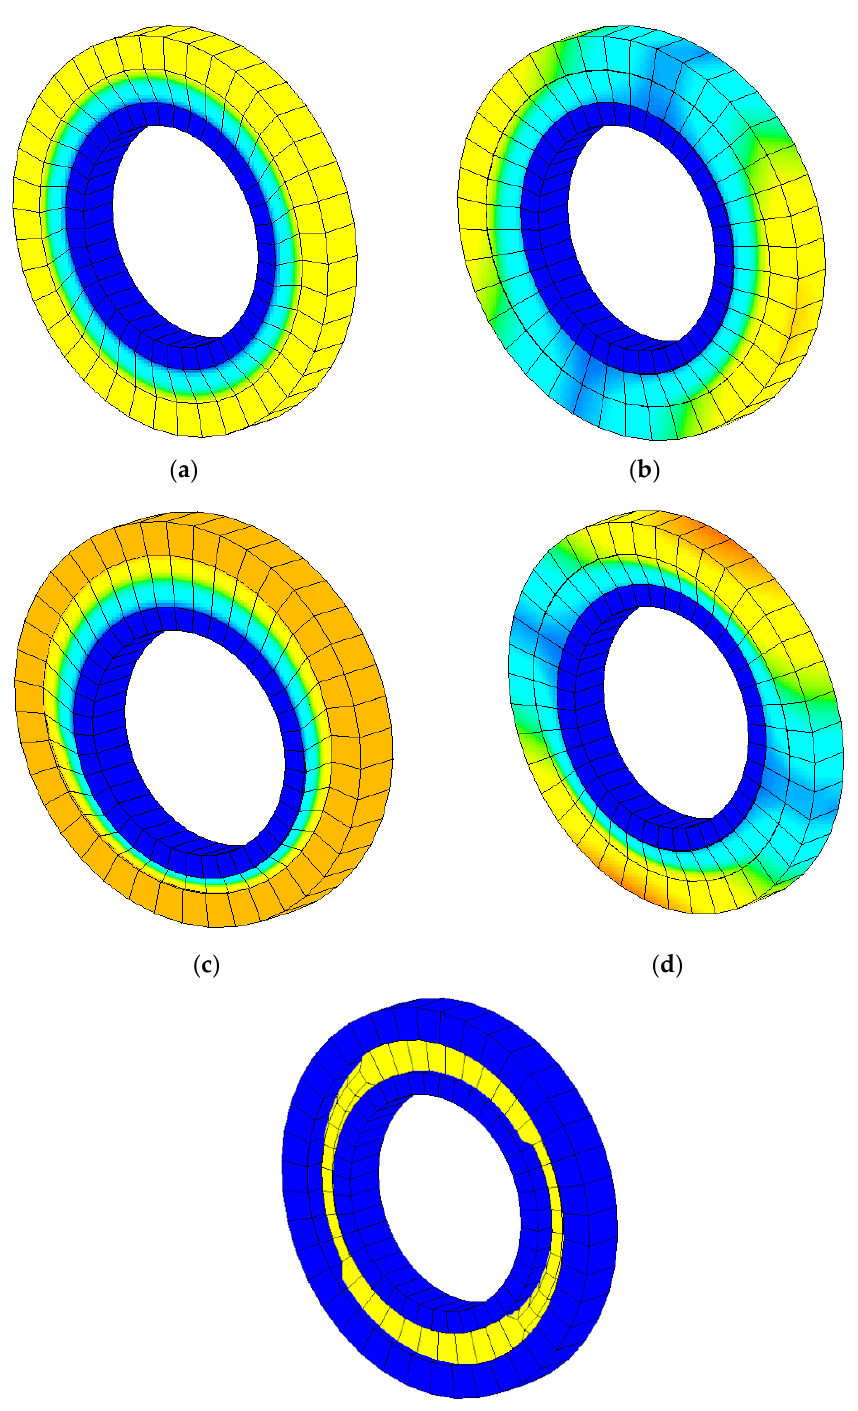
Figure 5. Orbits of the drill-string at the first three modes. ( a ) f = 0.0325 Hz (0.032 Hz, Khuleif et al. [8,15]); ( b ) f =0.0675 Hz (0.0677 Hz, Hhuleif et al. [8,15]); ( c ) f = 0.111 Hz (0.078 Hz, Khuleif et al. [8,15]).